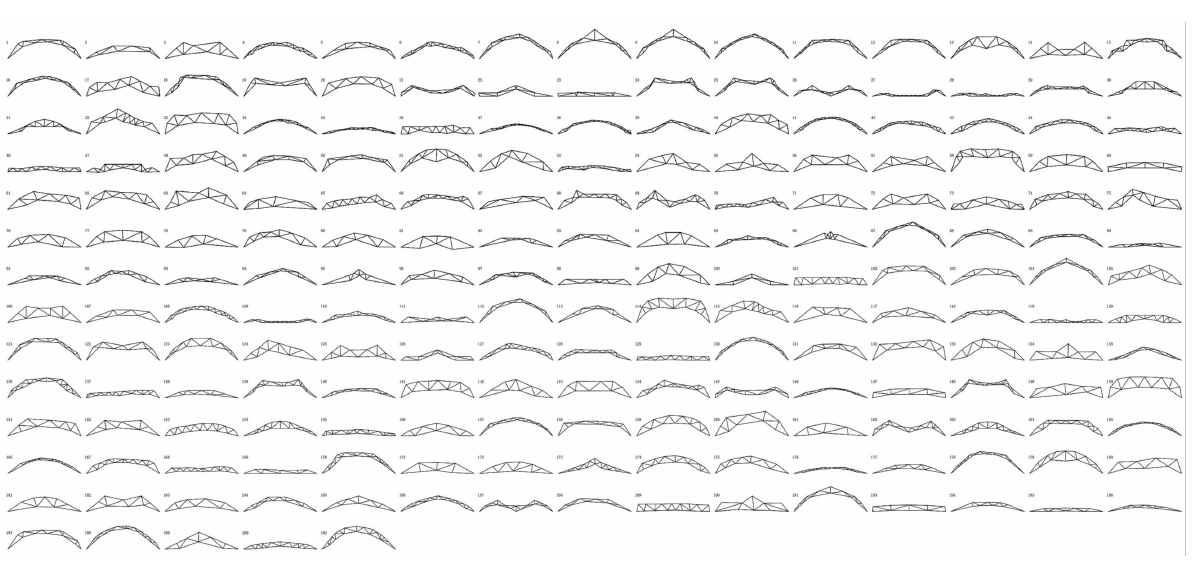
Figure 1. Sample population of truss